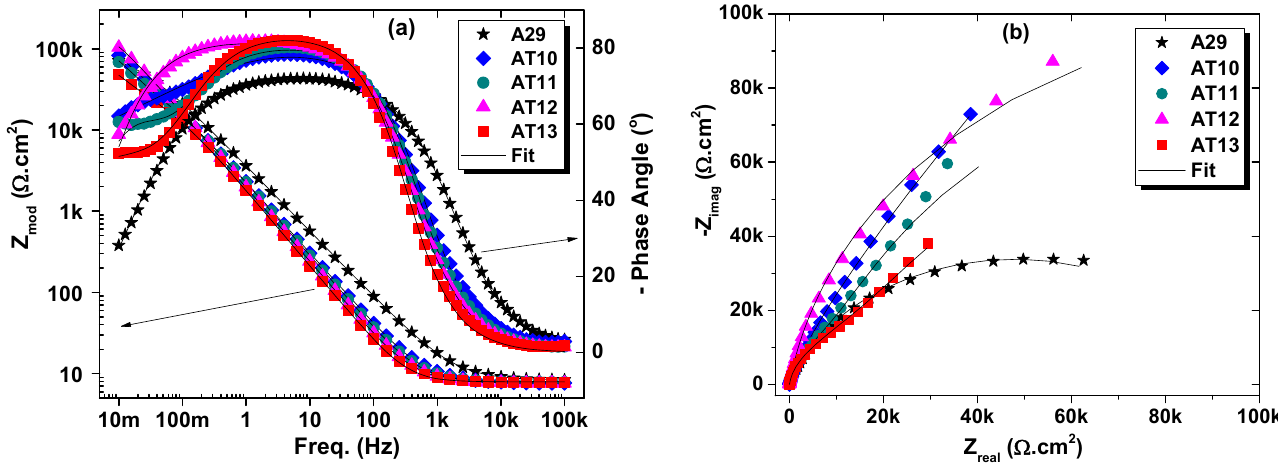
Freq. (Hz) Figure 11. EIS plots, ( a ) Modulus and phase angle, and ( b ) Nyquist plots, showing the effect of solutionizing temperature on the corrosion behavior of A29 after 1 hr immersion in 3.5% NaCl aerated solution .